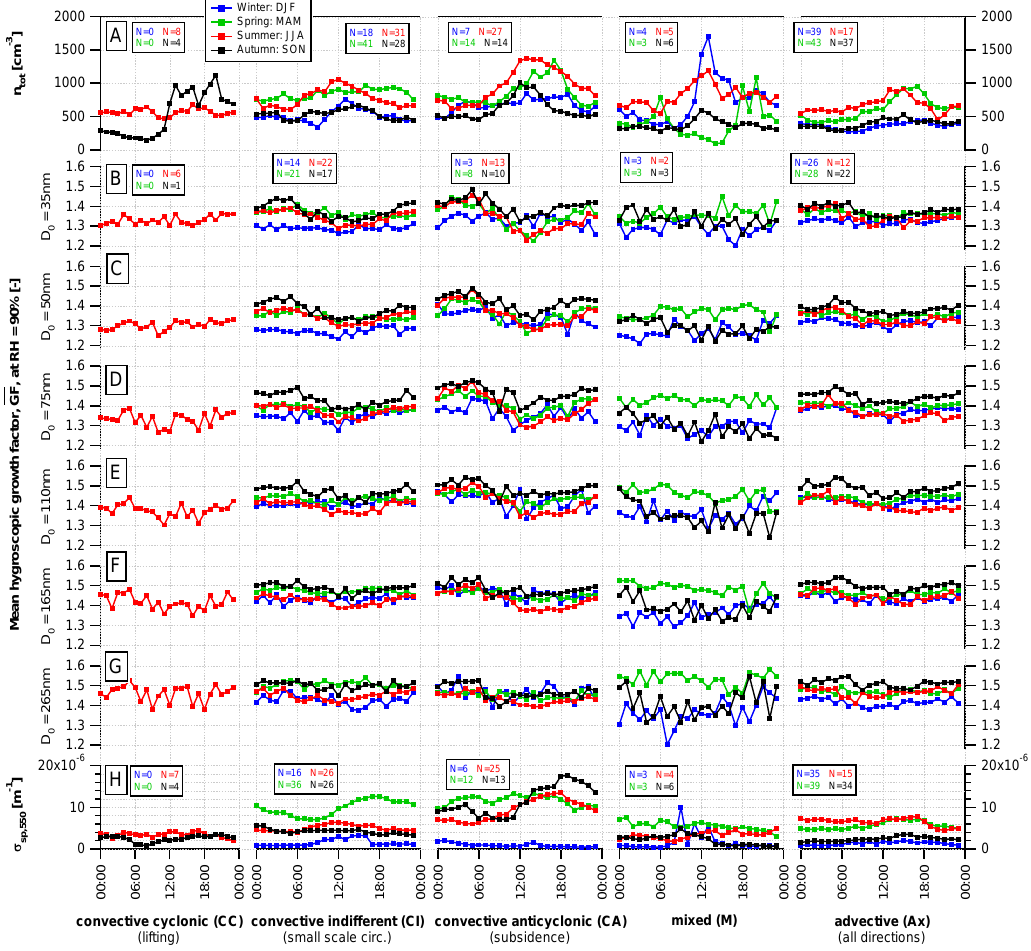
Fig. 5. Diurnal cycles (A) of the median of the total number concentration, (B–G) of the mean hygroscopic growth factor (GF) at 90% RH for D 0 =35, 50, 75, 110, 165, 265nm, and (H) of the scattering coefficient at the wavelength λ =550nm (green light). Data was split by the daily weather classes from the Alpine Weather Statistics and by